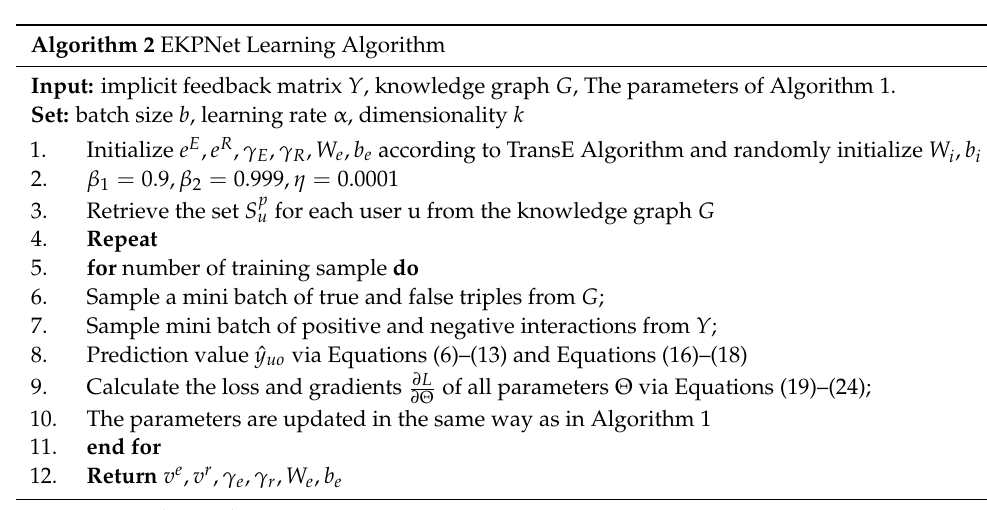
Algorithm 2 EKPNet Learning